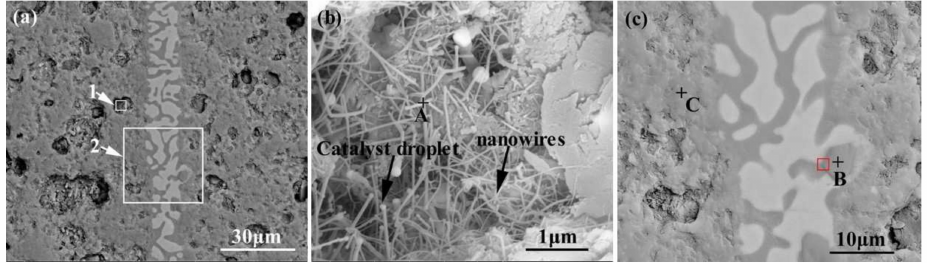
Figure 7. ( a ) Appearance characteristics of the carbon-coated welded joint bonded with SiCo38 alloy